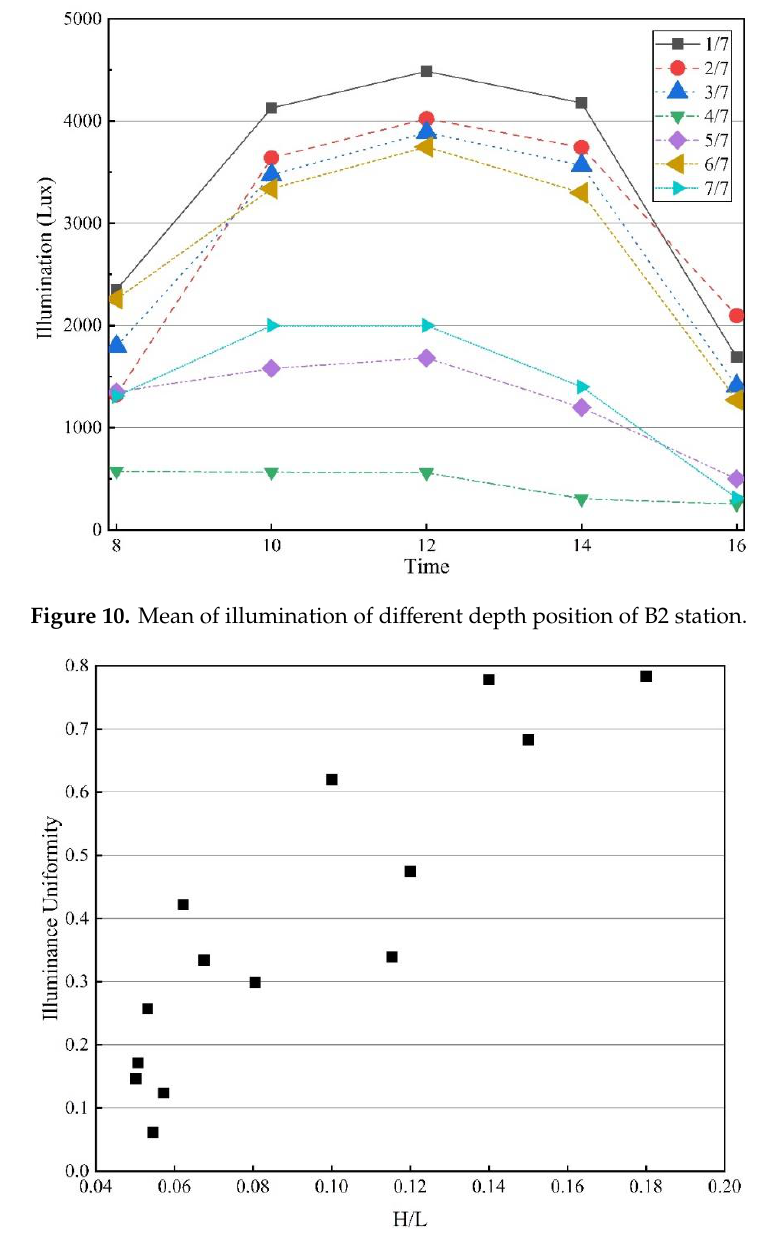
Figure 11. The relationship between illumination uniformity and station shape. H / L: The ratio between the height of the station and the length of the lighting direction. Illumination uniformity: The ratio of the lowest value of illumination to the average value.